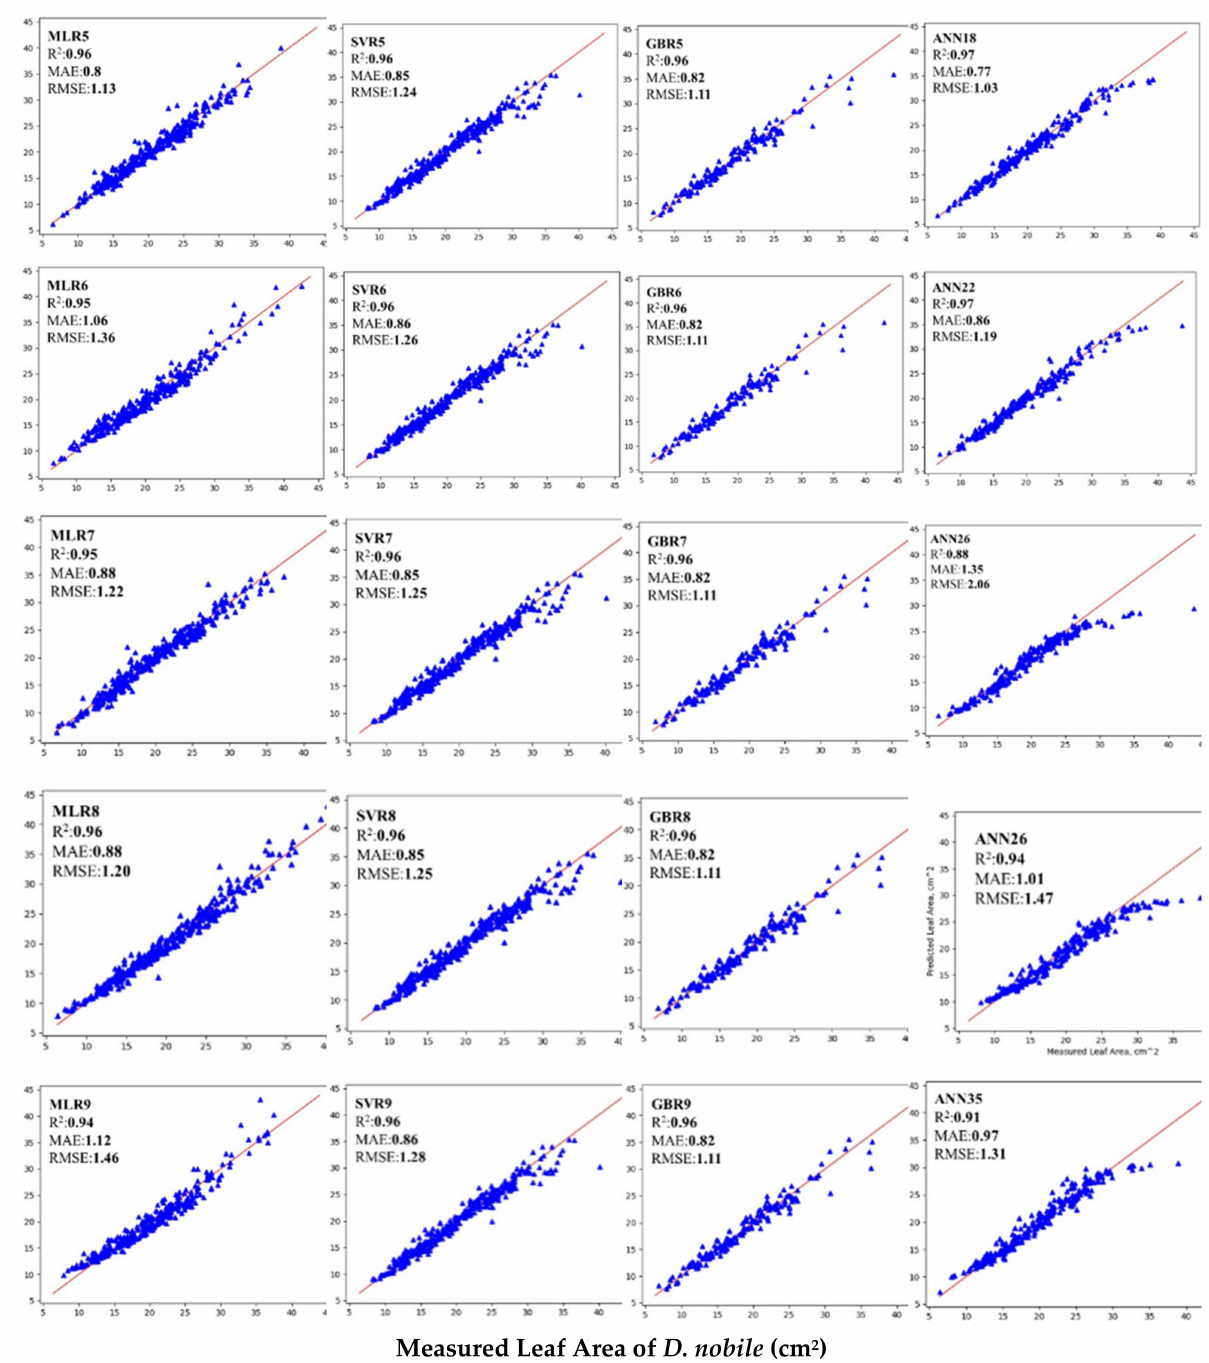
Figure 6. Comparison of predicted and measured values of leaf area of D. nobile using MLR, SVR, GBR, and ANN models in different input combinations. The x -axis represents measured values of leaf area by ImageJ software and y -axis denotes the predicted values by the two models above. The red line represents the reference line (y = x). Blue triangles represent the regression line of the predicted and measured leaf area. R 2 refers to the coefficient of determination, MAE refers to mean absolute errors and RMSE refers to root mean square errors (cm 2